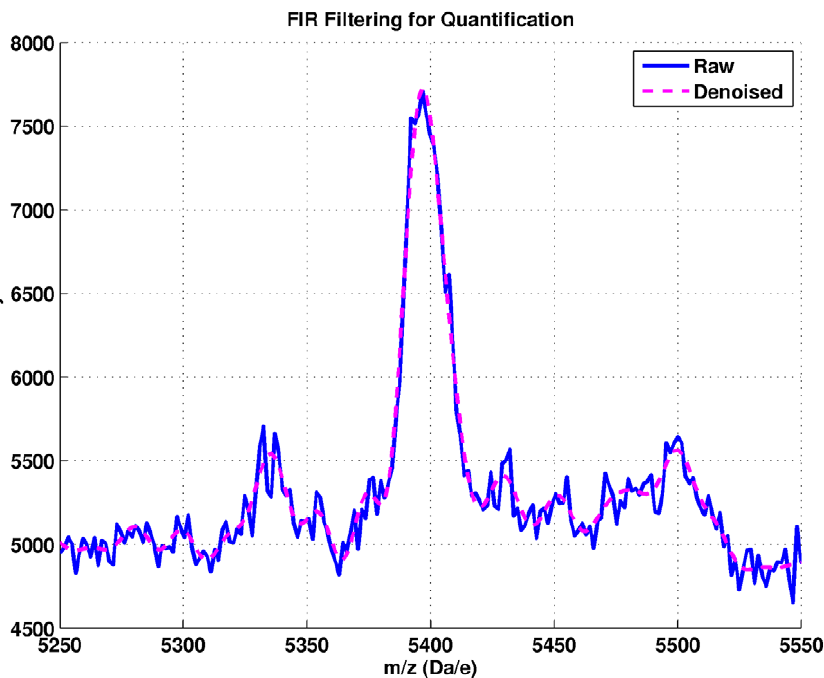
Figure 3. An example denoised peak using the FIR filter approach used for quantification. This is a typical example where the Antoniadis- Sapatinas denoising would find the peak but distort its peak height.